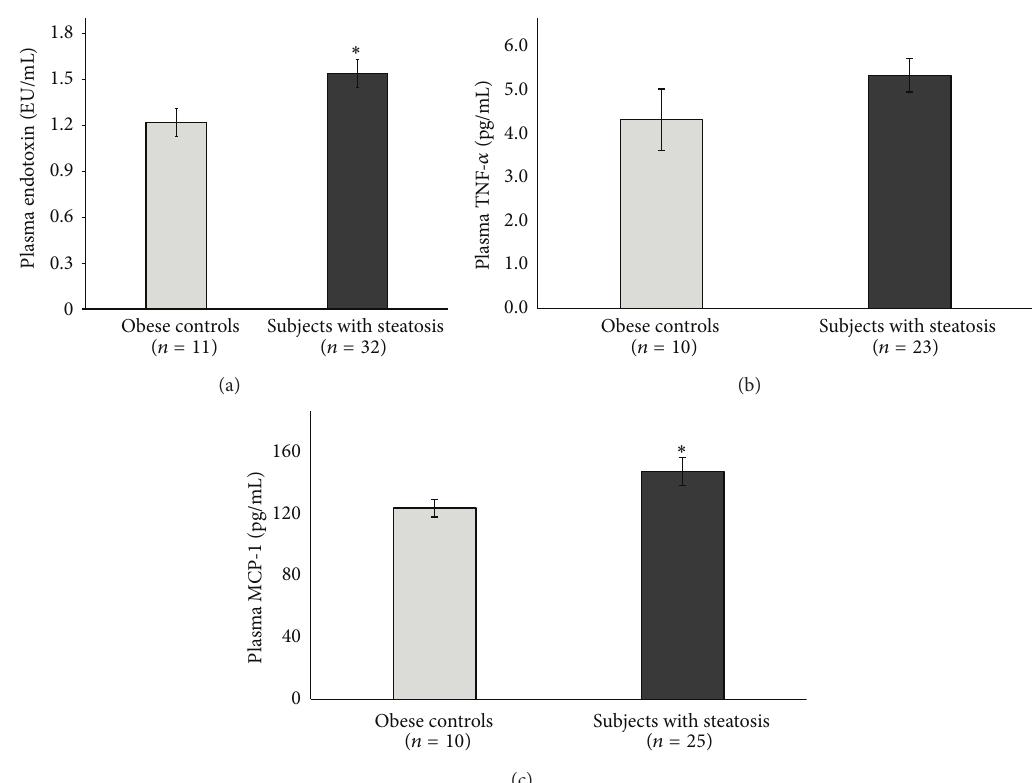
Figure 1: Obese adolescents with hepatic steatosis ( > 5% by MRS) had increased (a) plasma endotoxin levels, (b) plasma TNF- 𝛼 levels, and (c) plasma MCP-1 levels as compared to obese adolescents without significant steatosis (hepatic fat < 5% by MRS); ∗ 𝑃 < 0.05 .